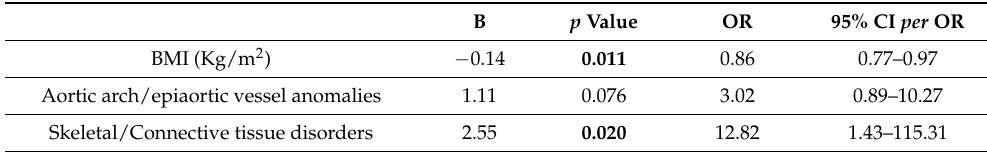
Table 4. Risk factors associated with ARD in 22q11.2DS